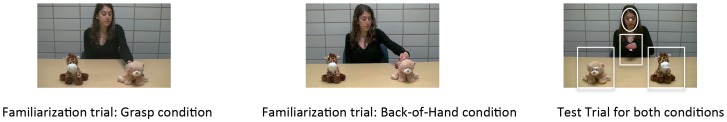
Examples of video stimuli.Depiction of the final video frames for the single familiarization trial in the Grasp and Back-of-Hand conditions, as well as the final video frame for a test trial. AOIs for the person and the objects were identically sized and shaped across conditions for the familiarization trial and for the test trials. The AOIs are depicted here for the test trial image. The individual featured in this figure has given written informed consent (as outlined in PLOS consent form) to publish these images.